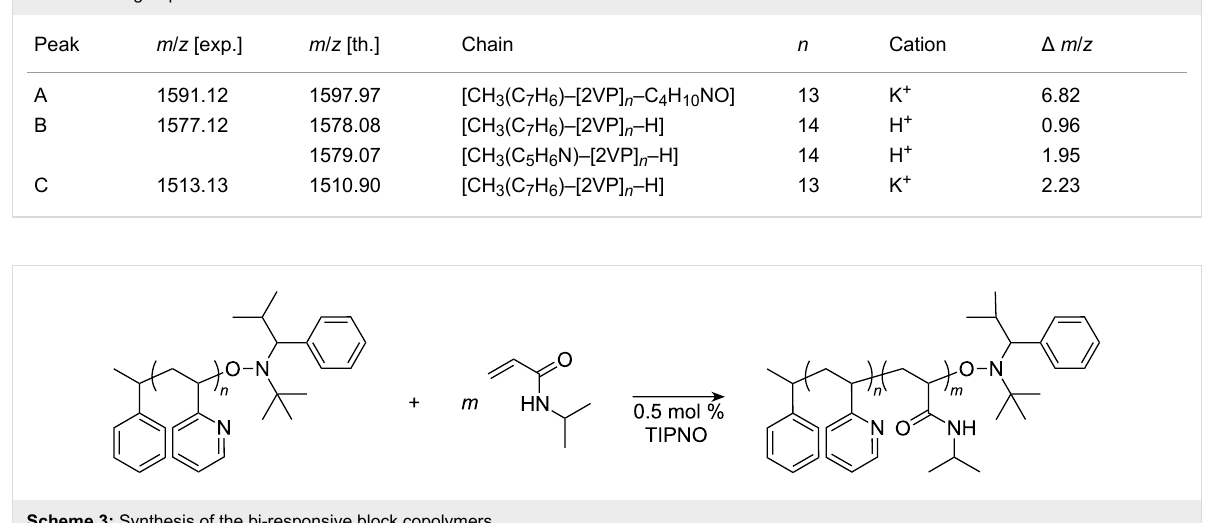
Figure 5: MALDI-TOF MS of P2VP obtained for polymerizations stopped after 2 h. The samples were prepared by the dried droplet method dissolving the polymer, DT, and KOTf in THF.